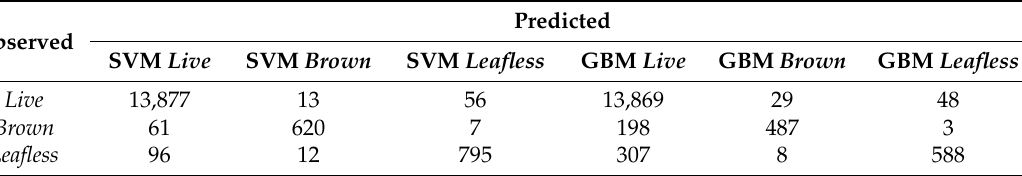
Table 2. Confusion matrix results from the cross-validation procedure of the optimal fit of the Support Vector Machine (SVM) model and Gradient-Boosted Machine (GBM) model. Here a likelihood value threshold of 0.5 was used for each